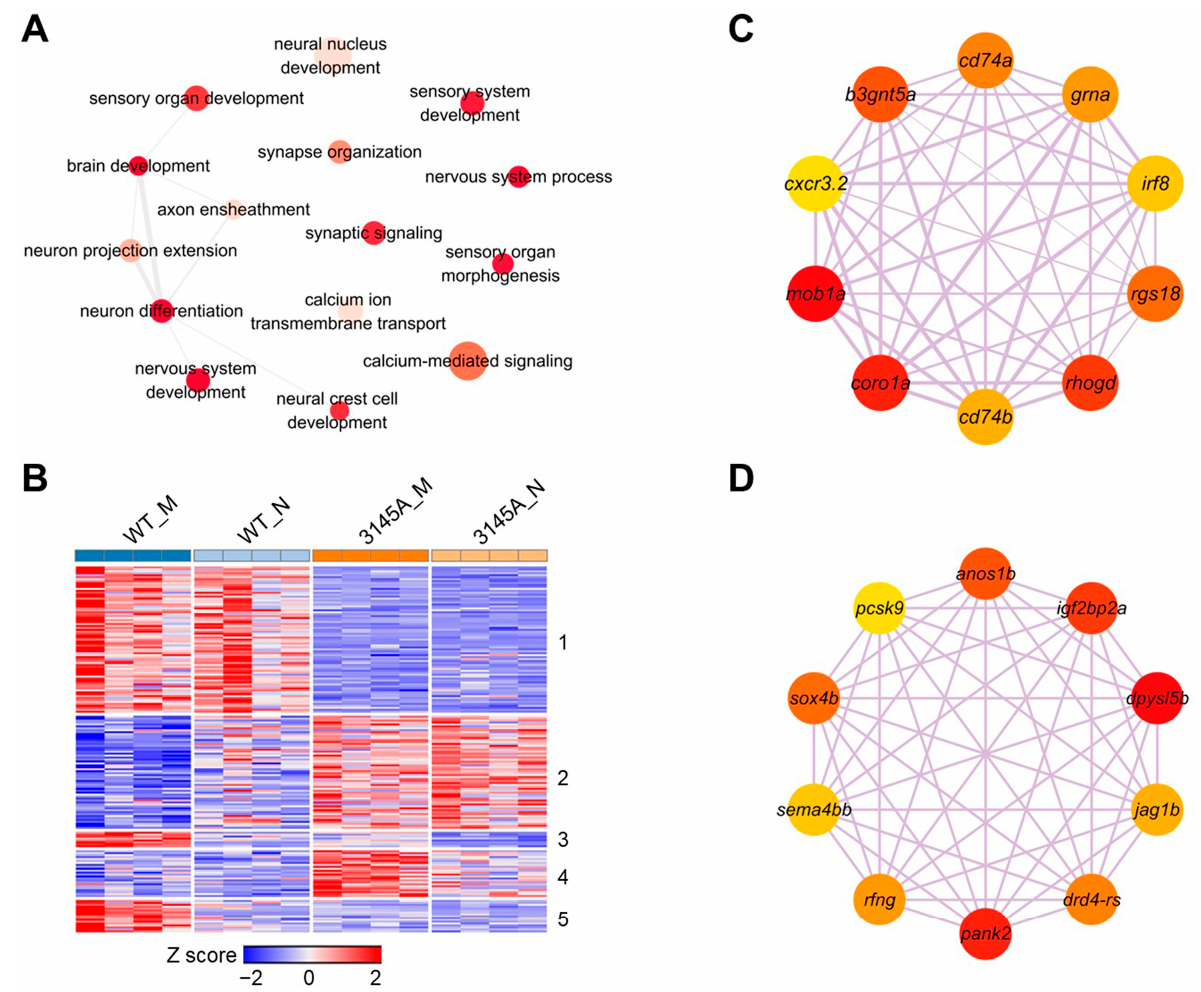
Figure 9. The genes affected by Prkcaa dysfunction and involved in neuron development and neural activity. ( A ) A network of the GO terms associated with neuron development and neural activity. The DEGs between WT and 3145A (both in morning and at night) were combined and subjected to GO enrichment analysis. Redundancy of the GO term list was removed by Revigo. Depth of color represents the p -value, and size of the nodes illustrates ratio of the DEGs associated with the corresponding GO term. ( B ) A heatmap demonstrating expression patterns of the genes affected by Prkcaa dysfunction and involved in neural functions. The genes were clustered into 5 clusters through the K-means method. ( C ) The Hub genes of cluster 1. ( D ) The Hub genes of cluster 2. Depth of color represents the p -value, and size of the nodes illustrates ratio of the DEGs associated with the corre-sponding GO